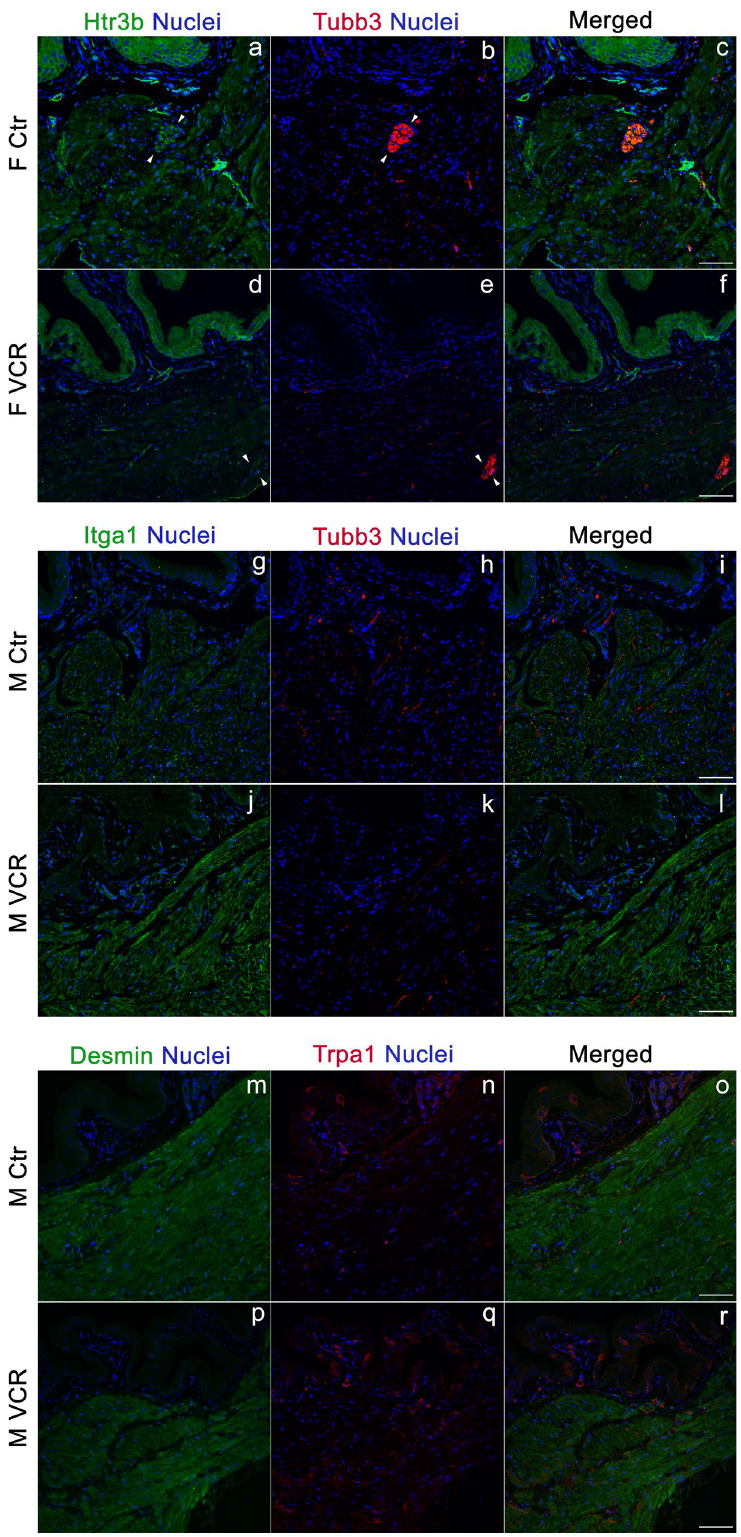
Figure 6. Immunofluorescence labeling of the bladders. Representative immunohistochemical images with antibodies against Htr3b (green, a and d ), Tubb3 (red, b and e ), and merged image ( c and f ) along nuclei staining using DAPI (blue) on the bladder sections from female mice in the control ( a – c ) and VCR ( d – f ) groups. Arrowheads indicate the cluster-forming Tubb3 IR. Representative immunohistochemical images on the bladder sections from male mice in the control ( g – i and m – o ) and VCR ( j – l and p – r ) groups with antibodies against Itga1 (green, g and j ), Tubb3 (red, h and k ), Desmin (green, m and p ), Trpa1 (red, n and q ) and merged image ( i , l , o , and r ) along nuclei staining using DAPI (blue). Scale bars = 250 µm. Figures were prepared using Adobe Photoshop